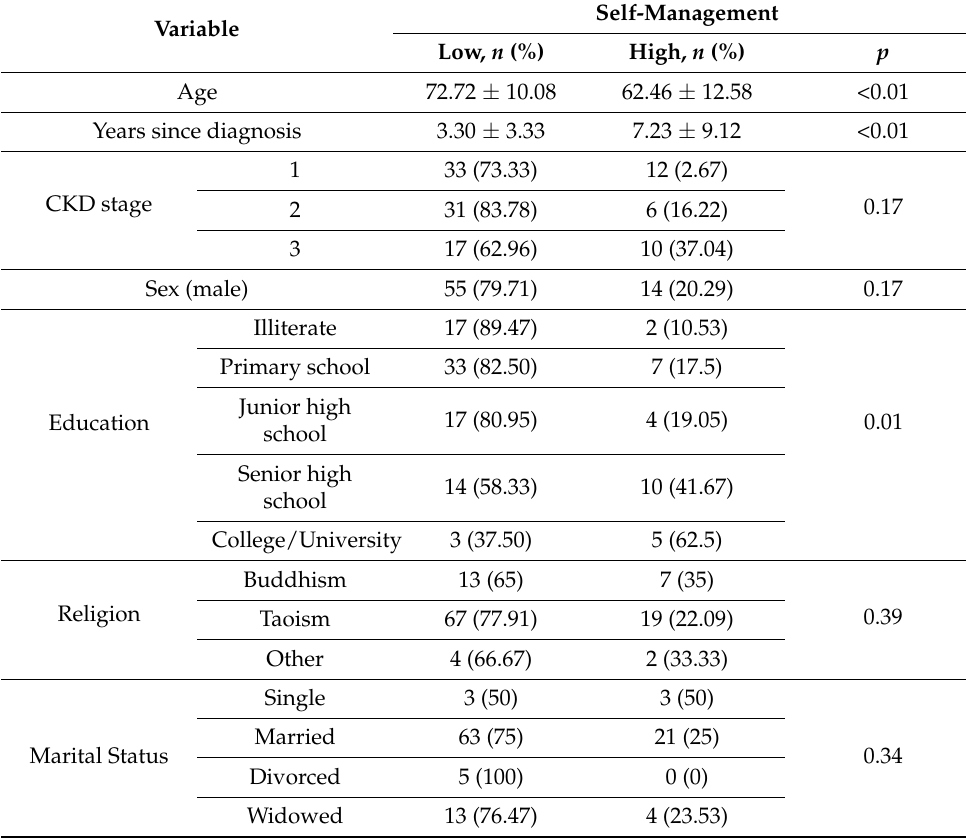
Table 3. Distribution of variables according to the self-management level of the study